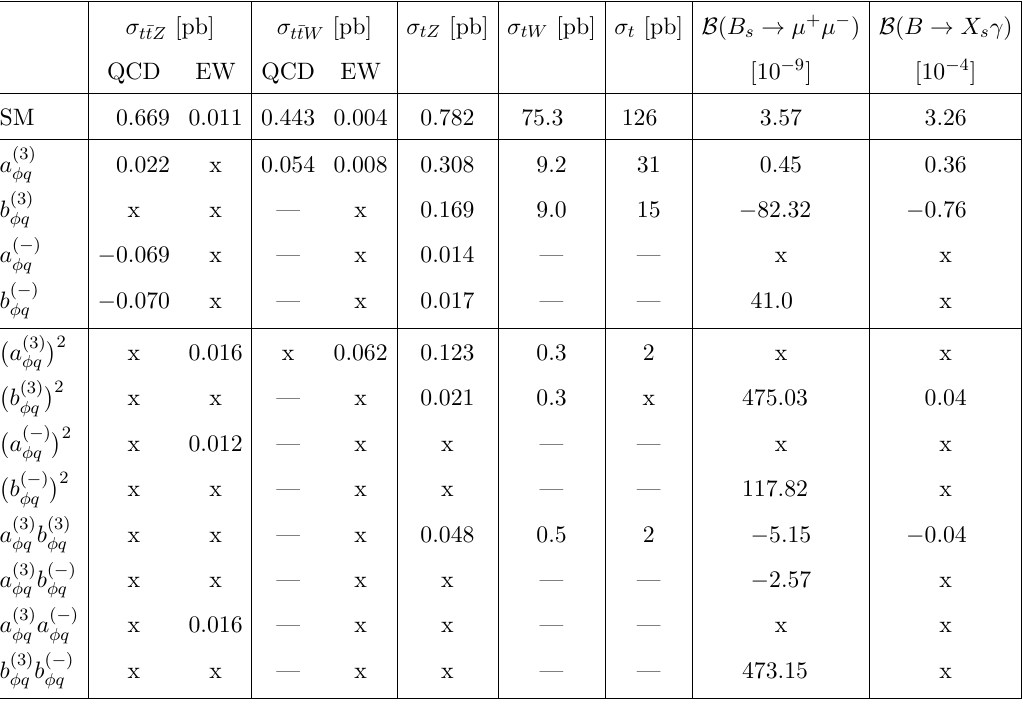
Table 9 . SMEFT contributions to top and flavor observables in MFV. The top observables are predictions for the LHC at 13 TeV. Contributions to σ production σ are given at LO QCD / EW; contributions to σ t SMEFT contributions to the flavor observables rely on one-loop SMEFT-to-WET matching in the electroweak theory and RG evolution at LO in QCD. The symbol x stands for contributions of less than 1% of the SM prediction and the symbol — stands for no